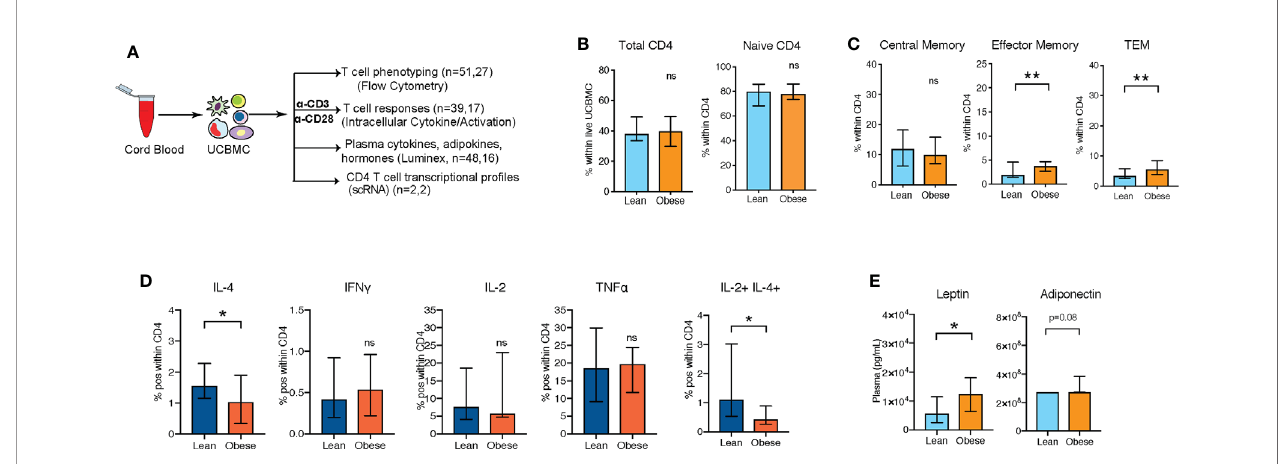
FIGURE 1 | UCB CD4 T cells from babies born to mothers respond poorly to polyclonal T cell activation (A) Experimental design: UCBMC from two independent cohorts of babies born to lean mothers and mothers with obesity were phenotyped and stimulated with CD3/CD28 dynabeads. Cytokine responses and activation markers were measured using fl ow cytometry. Plasma cytokines, chemokines, growth factors, metabolic hormones, and adipokines were measured using luminex. (B) Percentage of total CD4+ T cells within UCBMC and naïve cells within CD4+ T cells (n=51, 27) (C) Relative abundance of memory subpopulations within CD4+ T cells (n=51, 27). (D) Percent IL-4+, IFN g +, IL-2+, TNF a + CD4+ T cells, and IL-2+IL-4+ CD4+ Tcells in response to CD3/CD28 stimulation. Error bars show medians with interquartile range (IQR) (n=39,17) (E) UCB plasma levels of leptin and adiponectin with maternal obesity (n=48,16). (p-values: * - p < 0.05; ** - p <